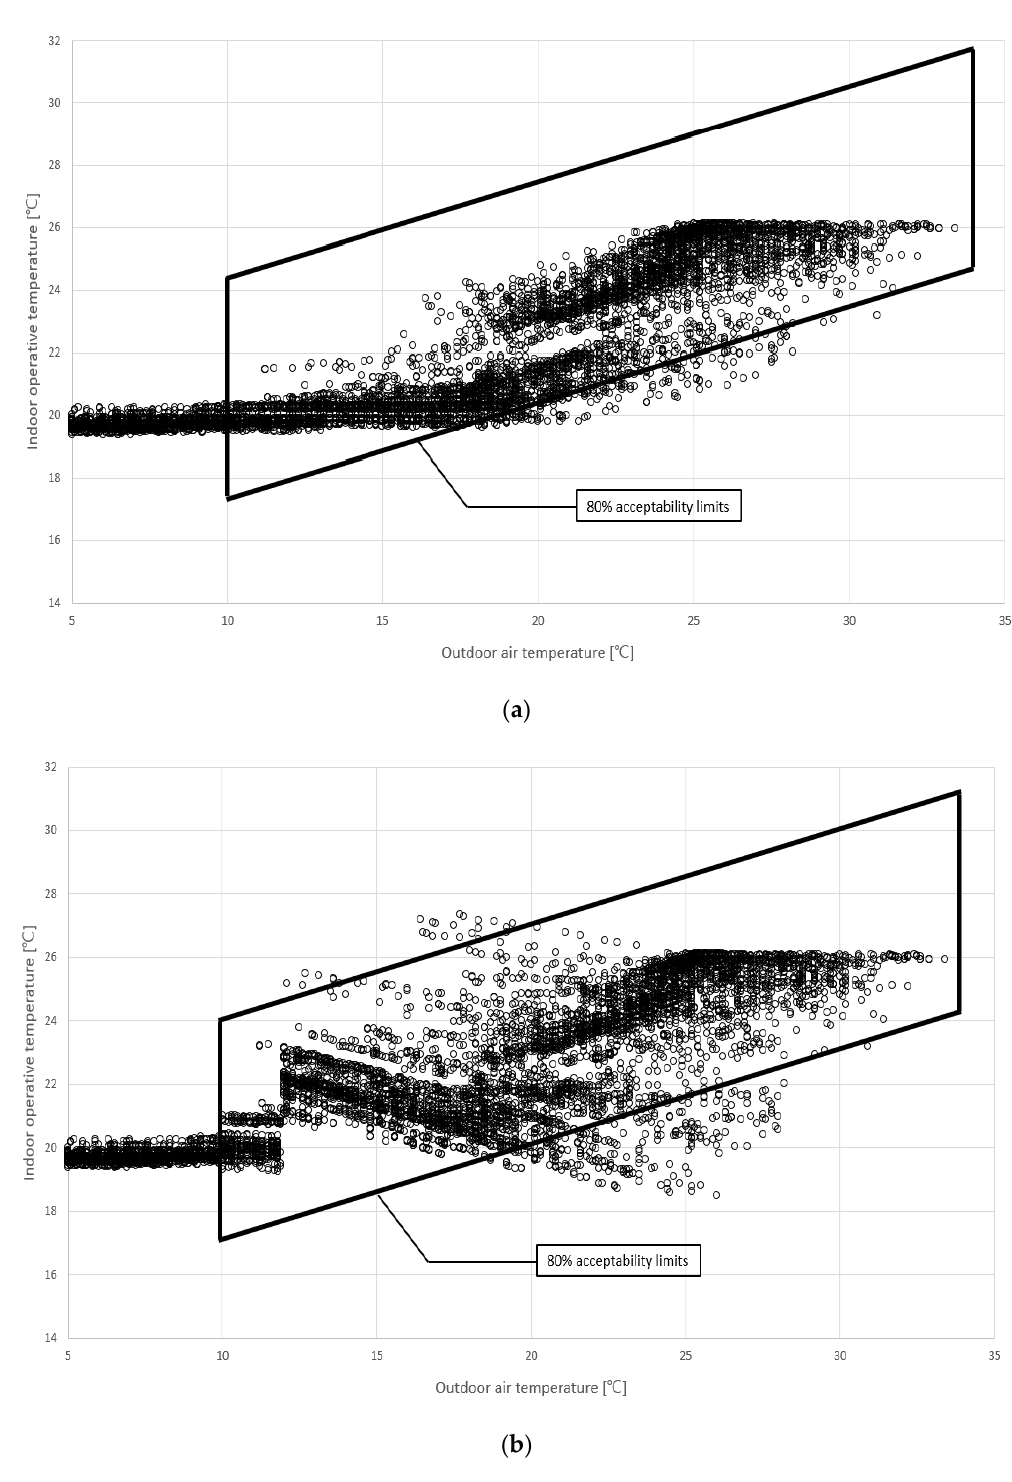
Figure 12. ( a ) Acceptability limits (80%) of operative temperature for naturally conditioned space in Case 1 (basic ventilation). ( b ) Acceptable hour (80%) of a year in case 4 (proposed solution). (cid:16) (cid:17) Finally, PMV, which is most widely used as a thermal comfort index, was analyzed. PMV = L body 0.303 e − 0.036 M + 0.28 where: PMV = Predicted Mean Vote; mal comfort ratings using this index, as shown in Figure 13. PMV is calculated using the M = Metabolic rate; L body = Thermal load on the